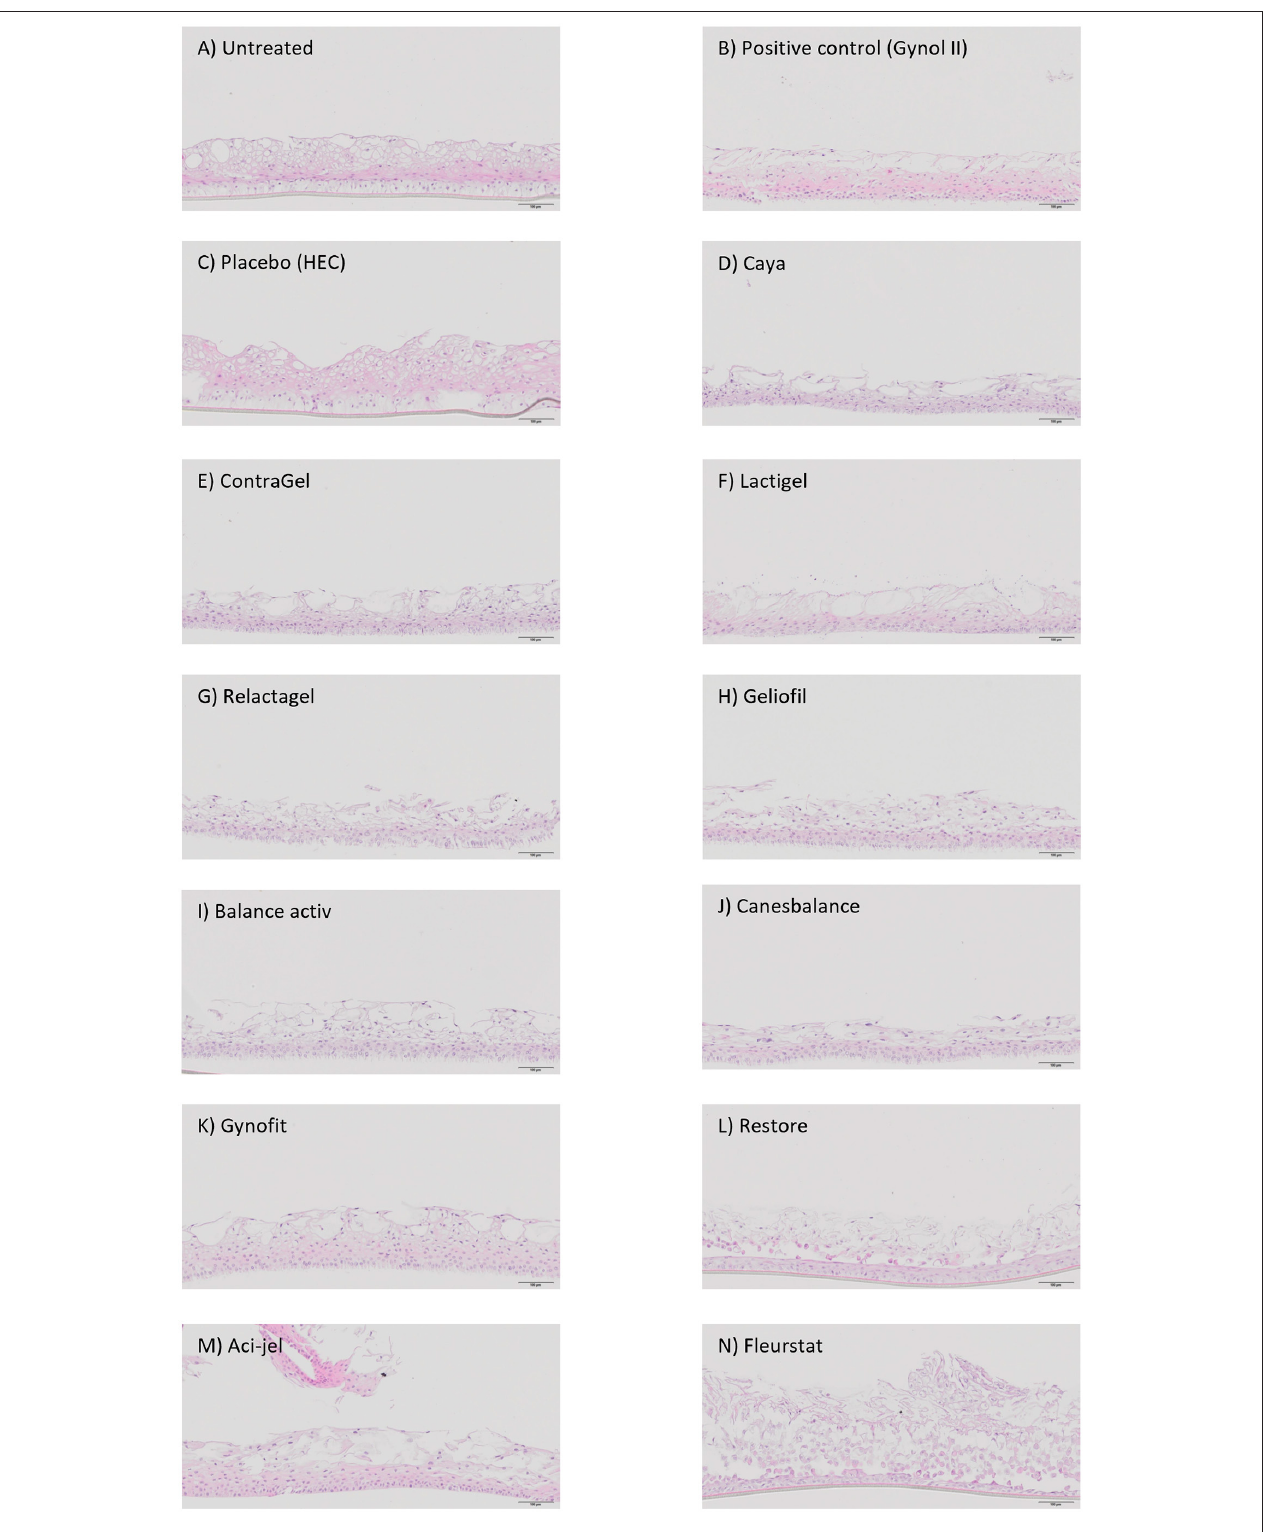
FIGURE 3 | Histological analysis of EpiVaginal tissue. The impact of over-the-counter gels on the structure and morphology of the cervicovaginal epithelium was assessed microscopically after 24h of treatment using hematoxylin and eosin staining. (A-N) show a representative image from each treatment.